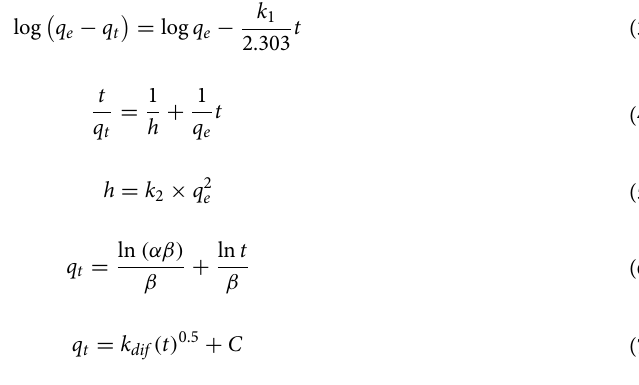
Initial CR concentration and adsorption isotherm. In this step, various concentrations of CR (10–300 mg L −1 , pH = 5.0) were tested (10 mg of adsorbent, 180 min contact time). Based on Fig. 8a, maximum adsorption capac- ities of 80.8, 90.1, and 99.9 mg g −1 were obtained for NC-1%, NC-3%, and NC-5%, respectively, for CR